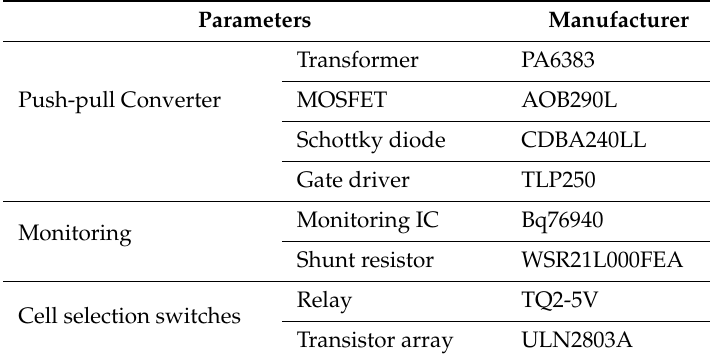
Table 2. Component list of the proposed cell balancing circuit. Figure 7 . Proposed cell balancing circuit for twelve Li ‐ ion batteries. Table 2 . Component list of the proposed cell balancing circuit.